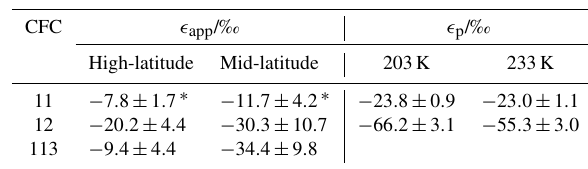
Table 2. The apparent isotopic fractionation, (cid:15) app , derived from our stratospheric measurements and the photolytic isotopic fractiona- tion, (cid:15) p , measured by Zuiderweg et al. (2012). All uncertainties are 1 standard